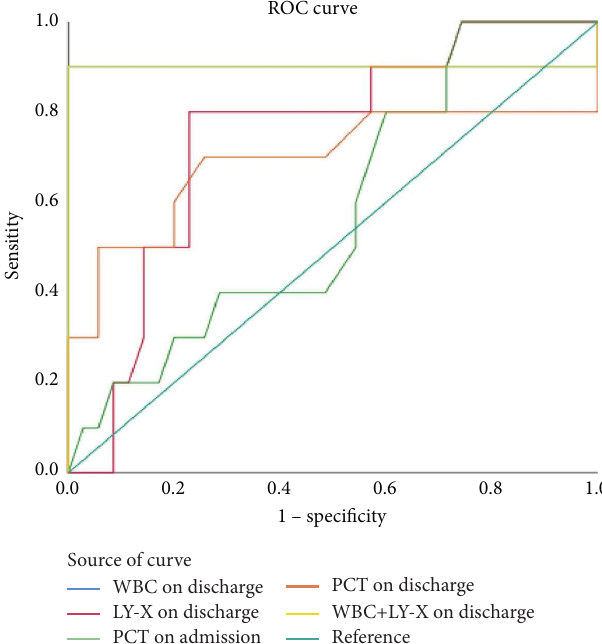
Figure 4: ROC curve of leukocyte parameters and PCT predicting clinical outcome of sepsis patients.